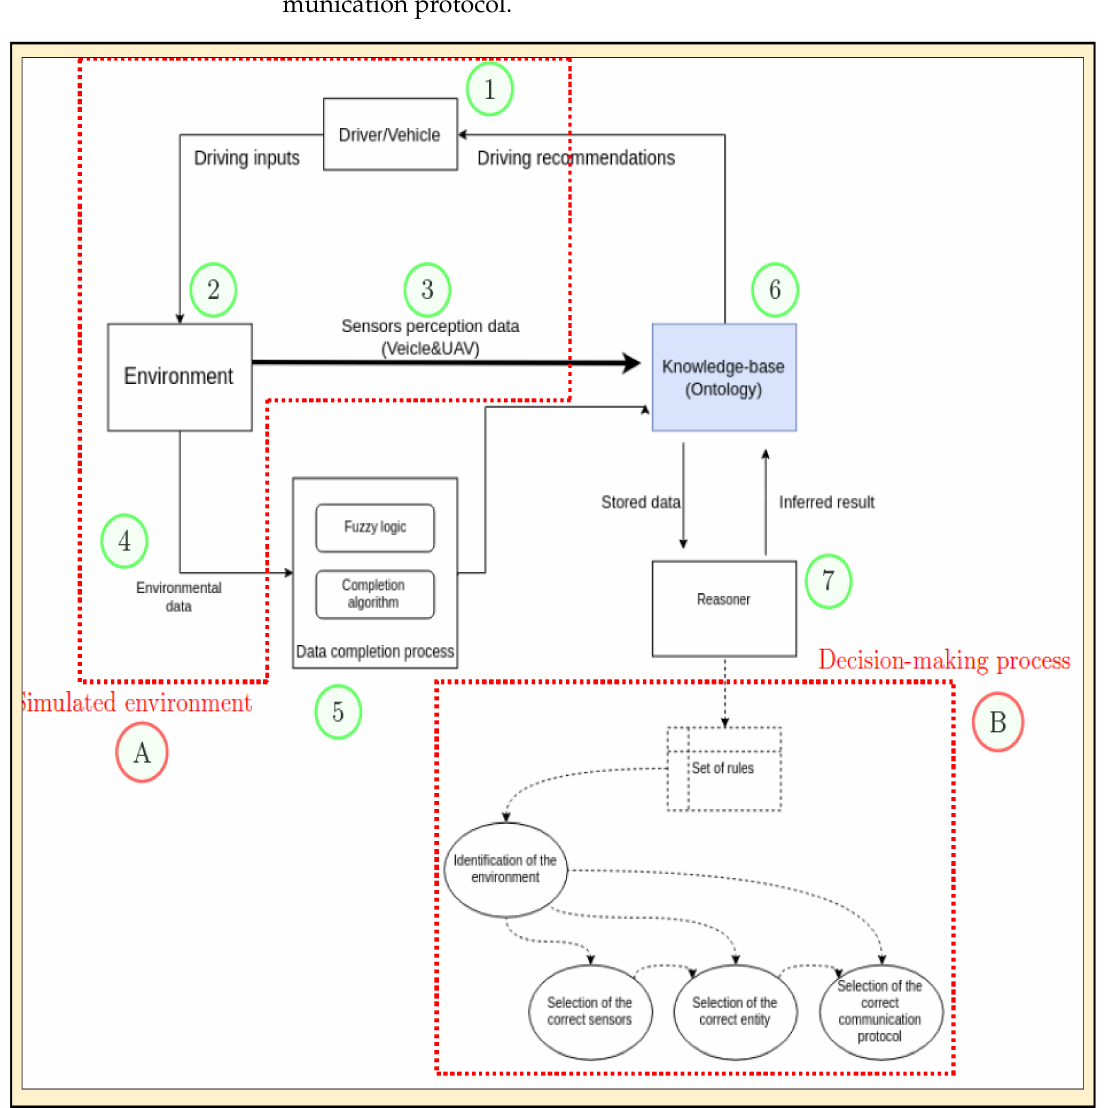
Figure 5. Enumerated approach and methodology used to enhance perception of driving